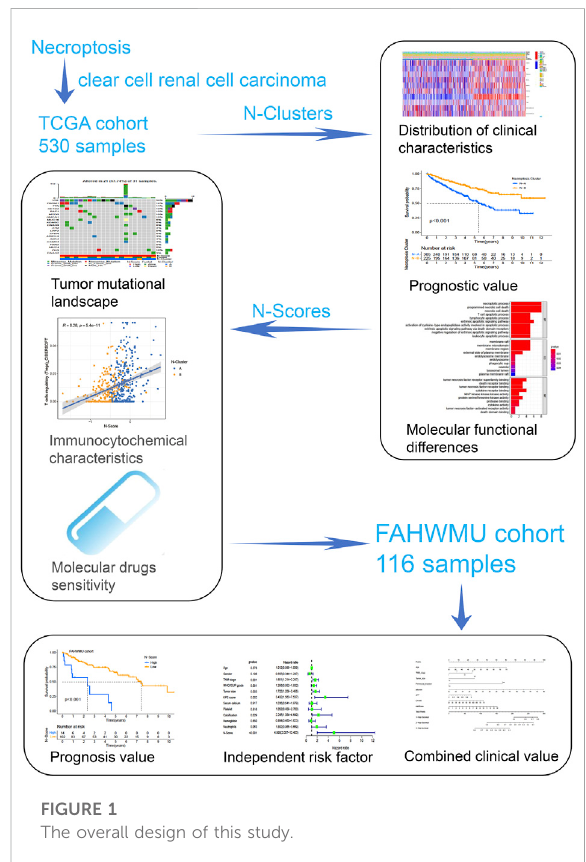
FIGURE 1 The overall design of this